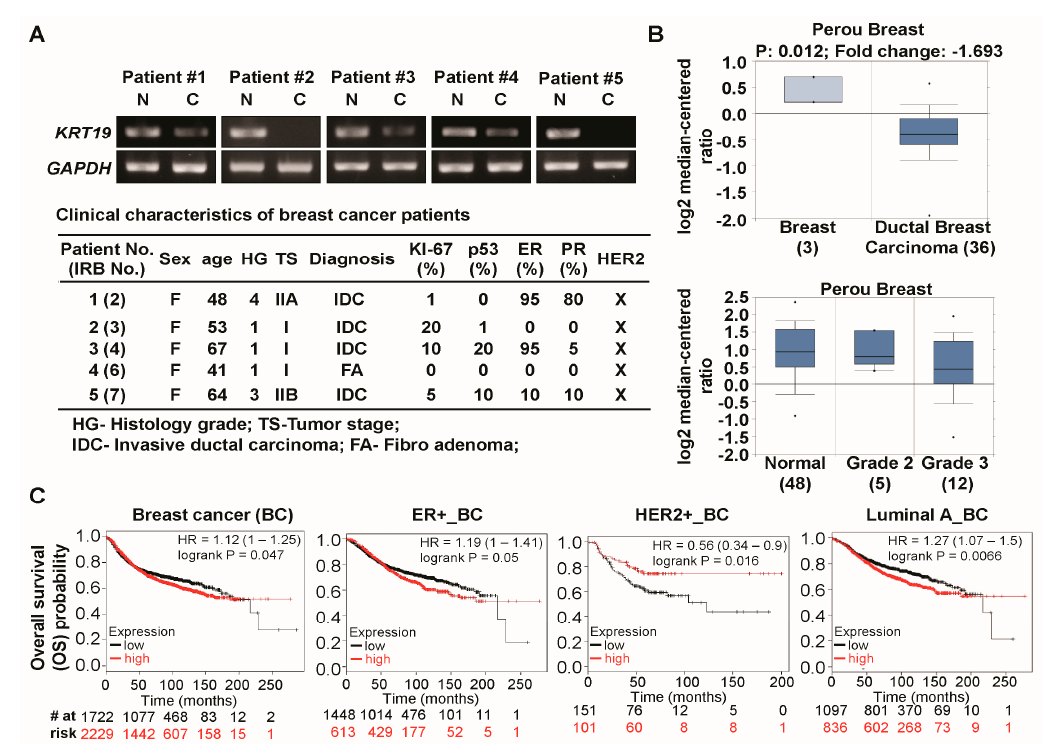
Figure 1. Expression pattern of KRT19 (keratin 19) in breast cancer and its clinical significance. ( A ) mRNA expression level of KRT19 was analyzed using reverse transcriptase polymerase chain reaction (RT-PCR) in breast cancer tissue (C; n = 5) as compared with adjacent normal breast tissues (N; n = 5). GAPDH was used as loading control (upper panel). Clinical characteristics of breast cancer patients for KRT19 expression (lower panel); ( B ) Relative levels of KRT19 expression was analyzed in normal and ductal breast carcinomas ( p = 0.012) (upper panel) and different tumor grade of ductal breast carcinomas (lower panel) using Oncomine databases. The image was downloaded from the Oncomine datasets provided by Perou et al. [49]; ( C ) Kaplan–Meier curves for overall survival (OS) probability of patients with breast cancer (BC) ( n = 3951); ER+_BC ( n = 2061); HER2+_BC ( n = 252); and Luminal A_BC ( n = 1933) expressing high and low expression levels of KRT19 .